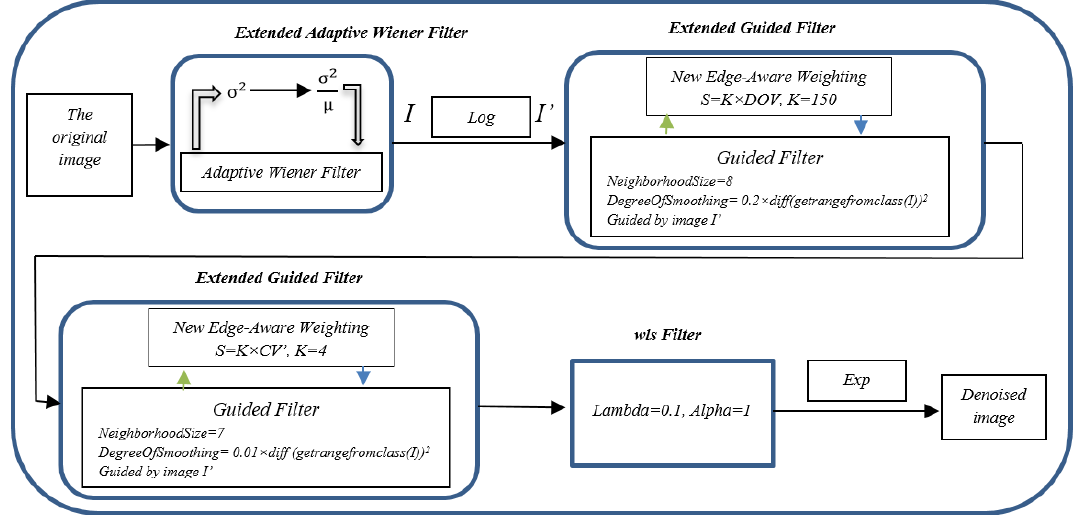
Figure 1. The flow diagram of the proposed algorithm.